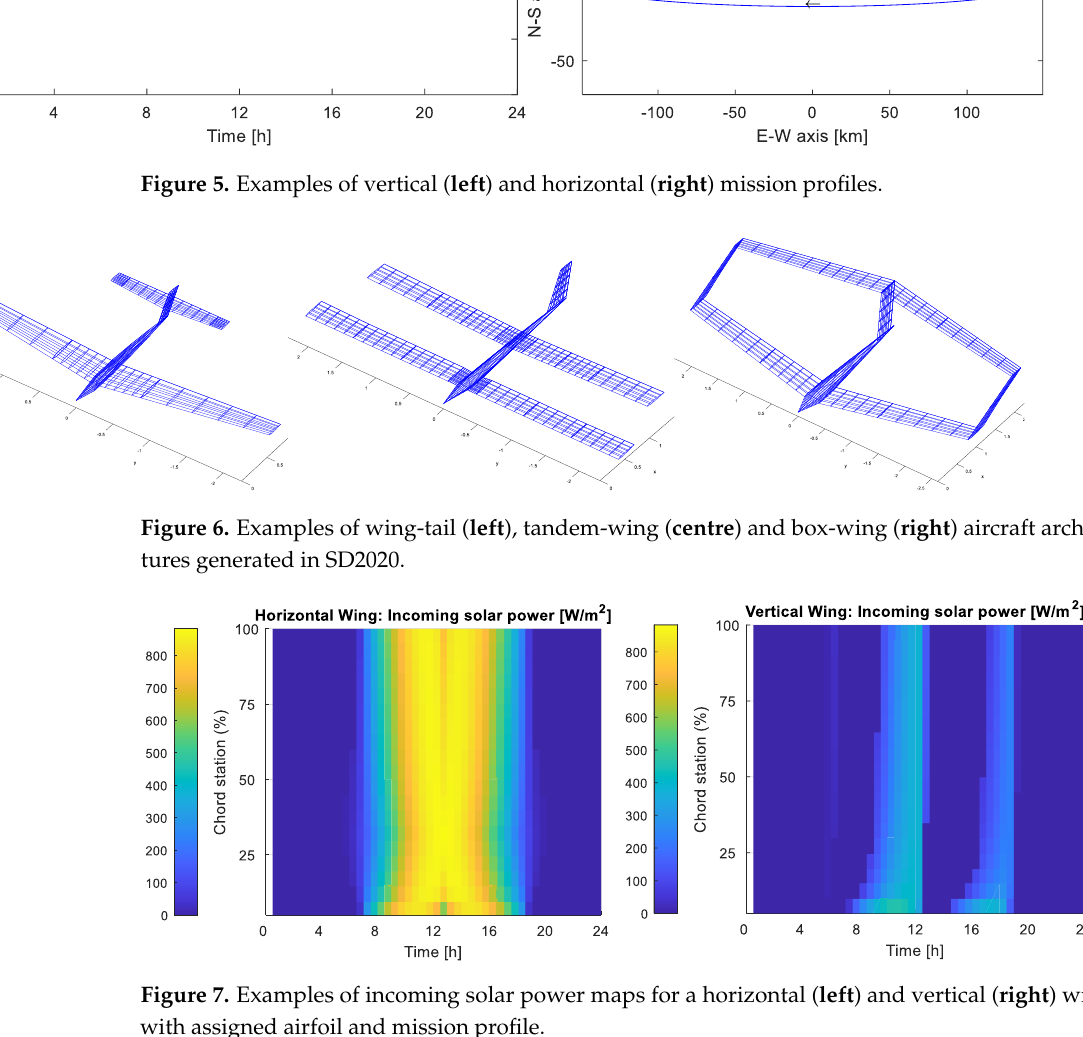
Figure 6. Examples of wing-tail ( left ), tandem-wing ( centre ) and box-wing ( right ) aircraft architec- tures generated in SD2020. •